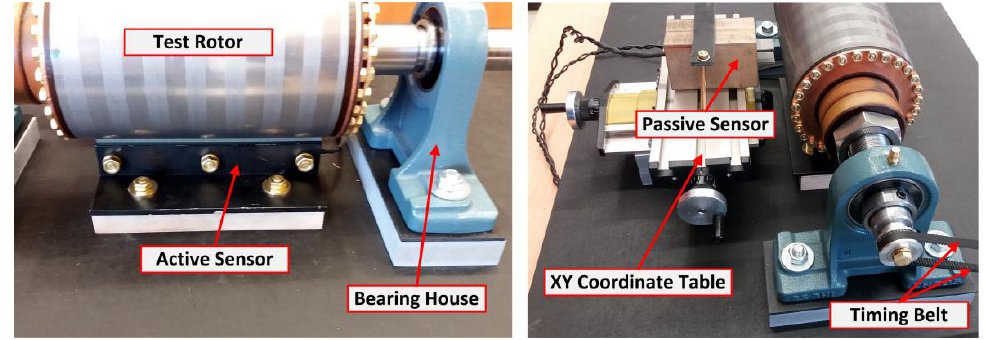
Figure 11. Overall view of the measuring system with test rotor.